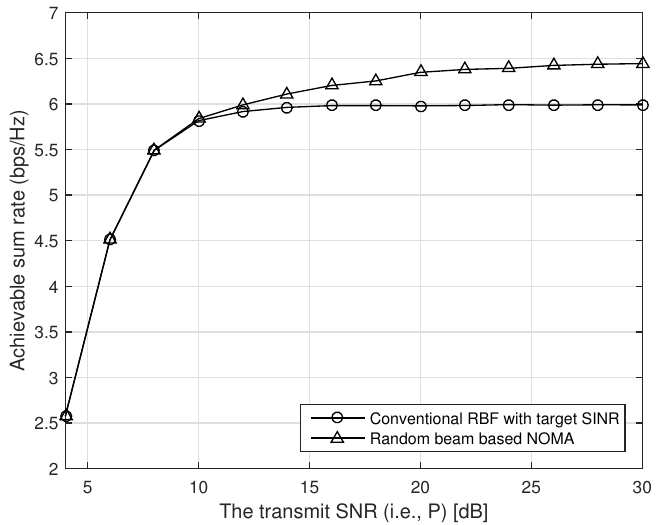
Figure 5. The performance of our proposed random beam-based NOMA with respect to the transmit SNR when the transmitter has six antennas, and the number of users is 200.